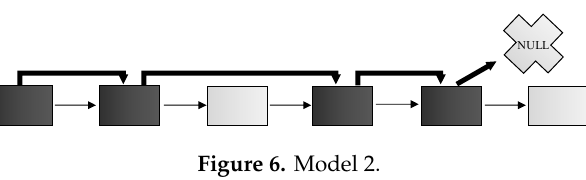
Figure 6. Model Figure 6. Model 2.